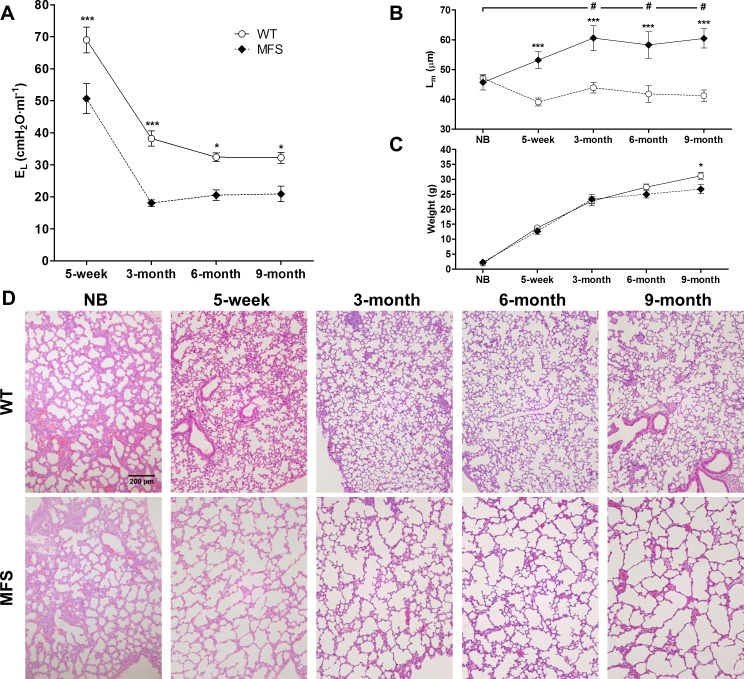
Airspace enlargement evolution in WT and MFS mice.(A) Effective lung elastance (EL) and (B) mean linear interecept (Lm) of alveolar septa in mice of different ages: from newborn (NB) up to 9-month old in wild-type (WT; open circles) and Marfan (MFS; closed black circles) mice. (C) Body weight along age in MFS and WT mice. (D) Panel illustrates examples of H&E stained lung sections. Images acquired at 100x magnification and scale bar represents 200μm. Data are mean ± SE. ***: p<0.001 between WT and Marfan animals and #: p<0.05 respective to new born mice in Marfan animals.